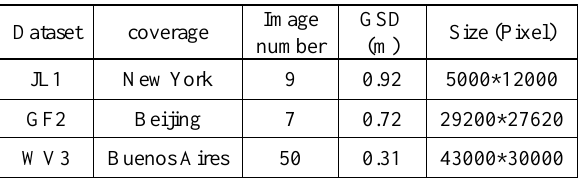
Table 1. Information of the